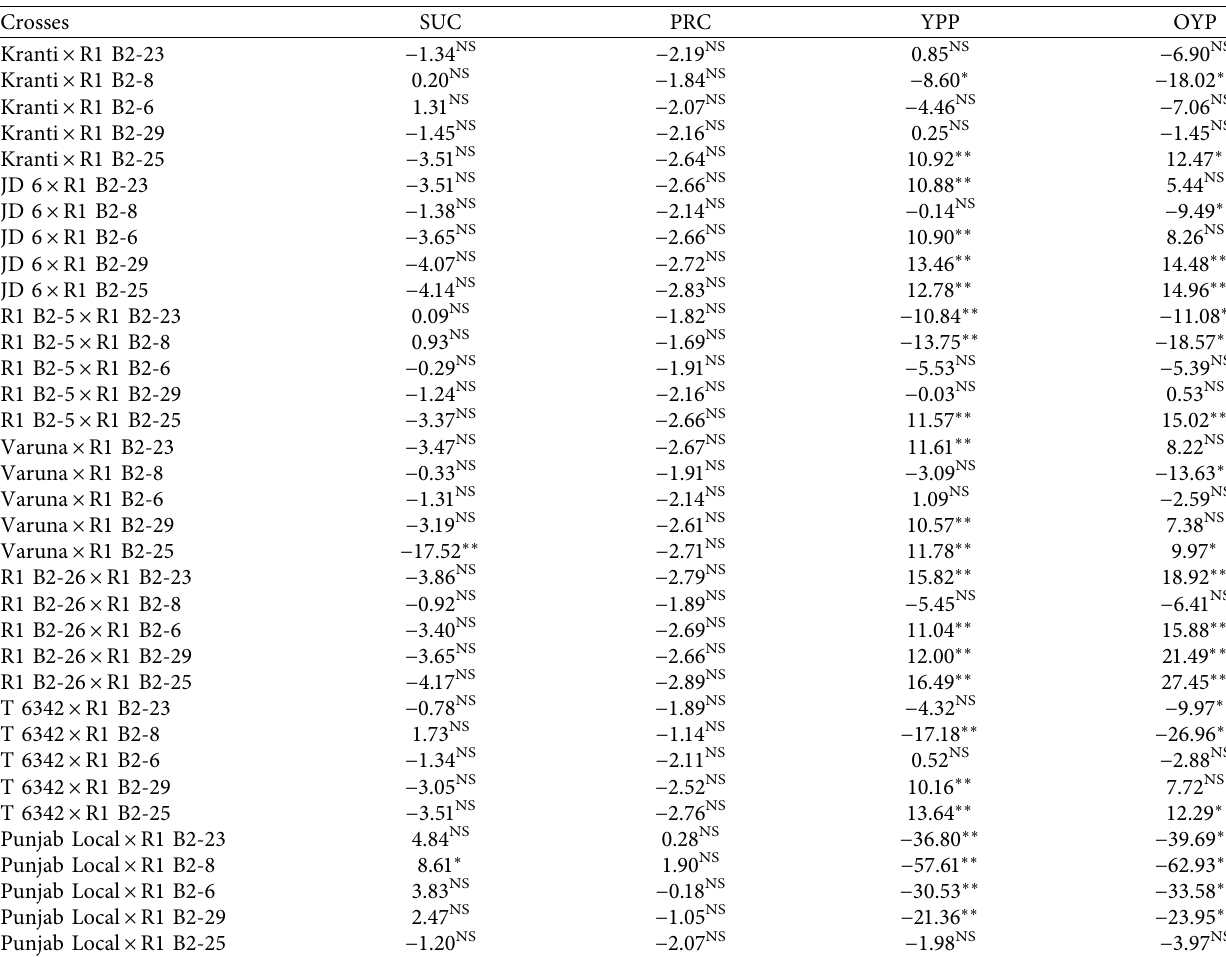
Table 20: Standard (economic) heterosis of mustard hybrids for yield and its attributed